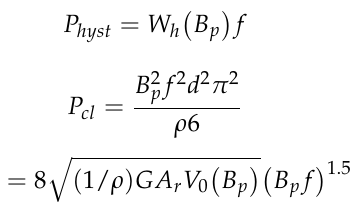
Figure 4. Approximated uni-axial relation between the stress correction factor of relative permeability K µ and the present stress state according to [9,10]. A factor higher than 1 means increased permeability due to stress. The relative permeability peaks at 140% of the stress-free permeability at a stress state of 10% of the material elastic limit, denoted by e/10 in this figure. This figure is valid for a material with elastic limit e = 350 MPa. For materials with a different elastic limit, the graph should be scaled accordingly.